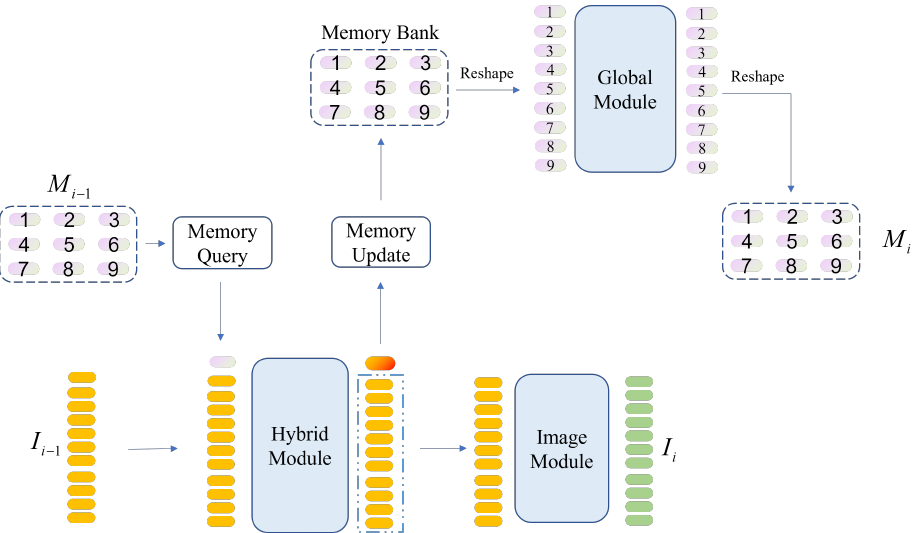
Figure 4. The extraction process of a single stage. M i , I i denotes the output memory token and image features of the i -th